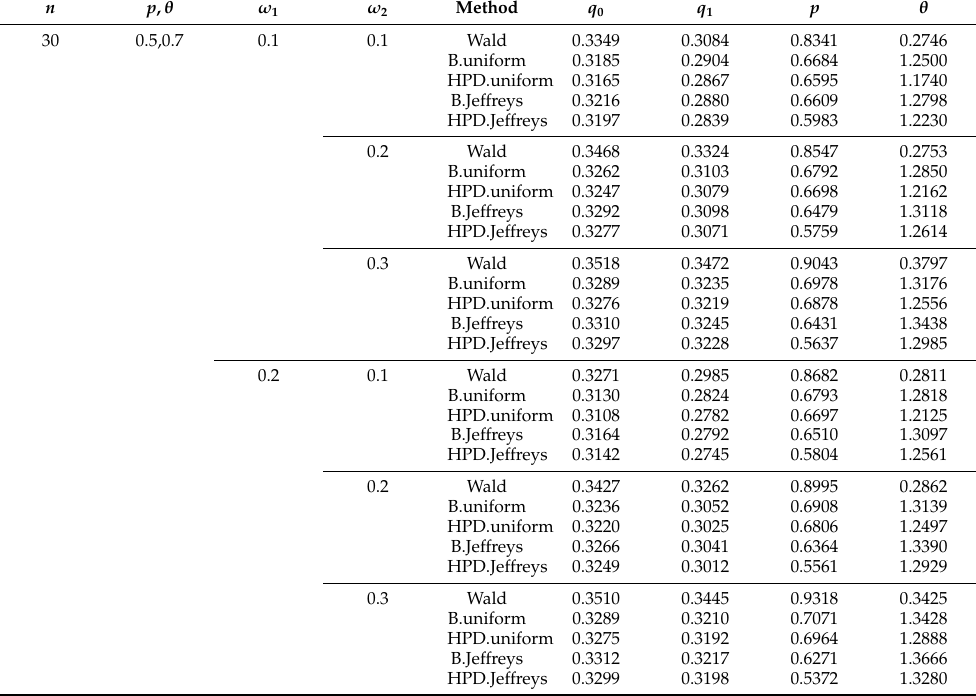
Table 2. Average length of parameter estimation for model in Equation